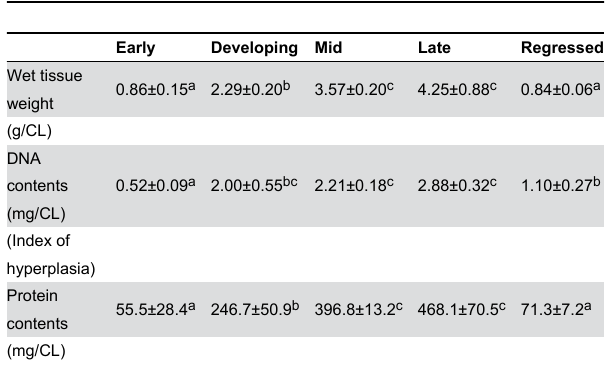
Table 2. Luteal weight, DNA and protein contents of bovine CL throughout the estrous